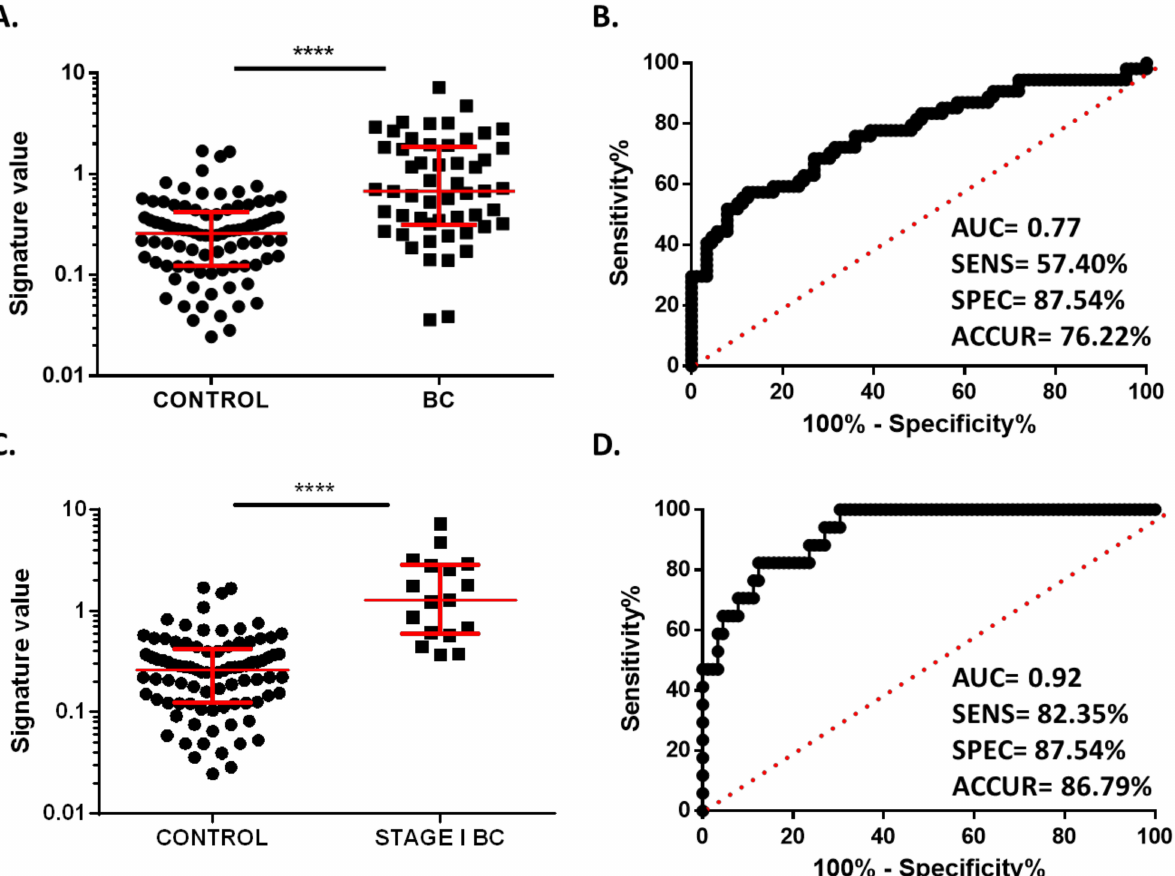
Figure 3. Diagnostic value of miR-30b-5p and miR-99a-5p combined signature. ( A ) Signature value of plasma samples of 54 BC patients and 89 healthy controls from discovery cohort. ( B ) Receiver operating characteristics (ROC) curve analysis of combined signature in plasma samples from discovery cohort. ( C ) Signature value of plasma samples of 17 stage I BC patients and 89 healthy controls from discovery cohort. ( D ) ROC curve analysis for combined signature in stage I BC patients. Red lines represent median ± interquartile range. **** p <